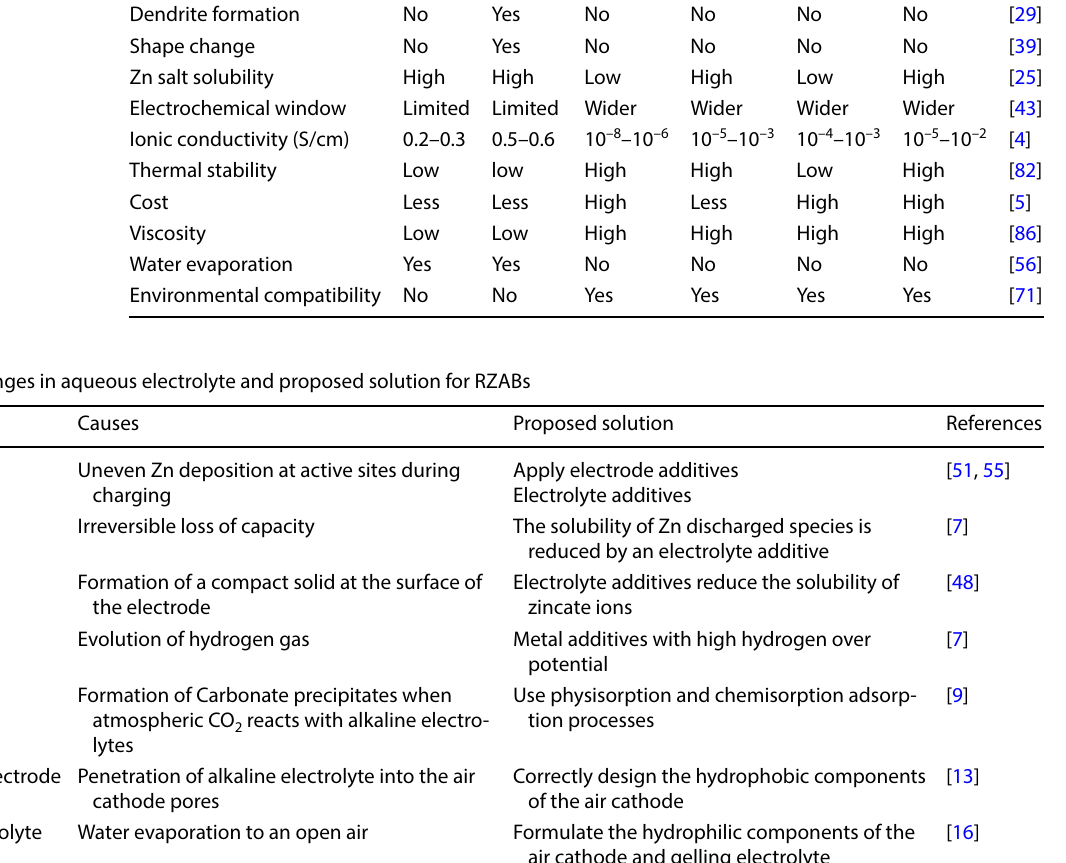
Table 3 Comparison electrolyte issues with different electrolyte systems for RZAB application [4, 5, 9, 25, 29, 39, 43, 56, 71, 82, 86]